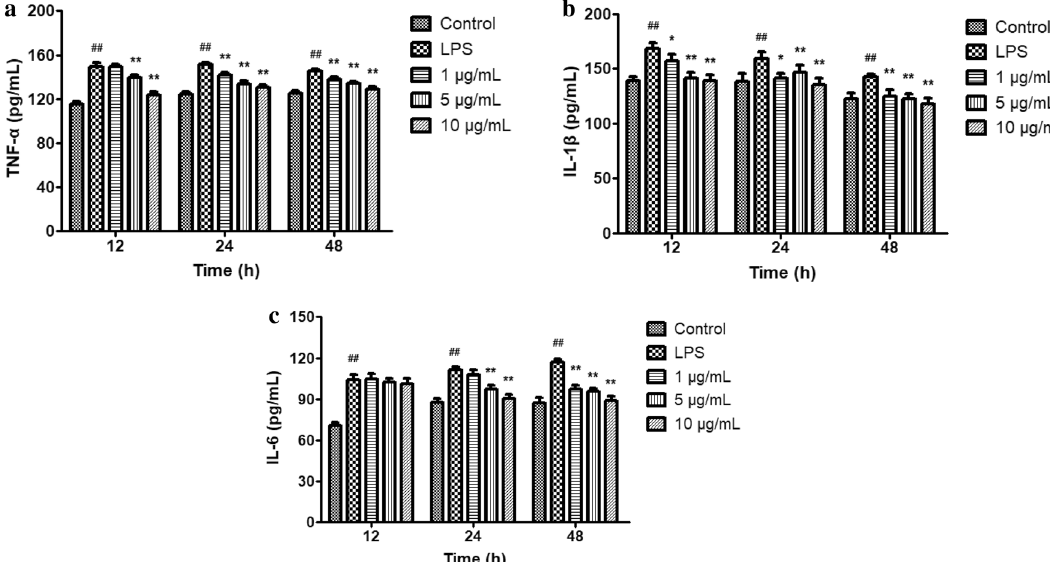
Figure 4. Effect of licochalcone A on LPS-induced secretions of tumor necrosis factor-α (TNF-α) ( a ), interleukin-1β (IL-1β) ( b ) and interleukin-6 (IL-6) ( c ) in claw dermal cells. Cells were exposed to gradient concentrations of licochalcone A (1, 5, 10 μg/mL) with or without the presence of 10 μg/mL LPS for 12, 24, and 48 h, respectively. The data were presented as mean ± SEM (n = 6). ## P < 0.01 vs. control group; * P < 0.05 vs. LPS model group; ** P < 0.01 vs. LPS model